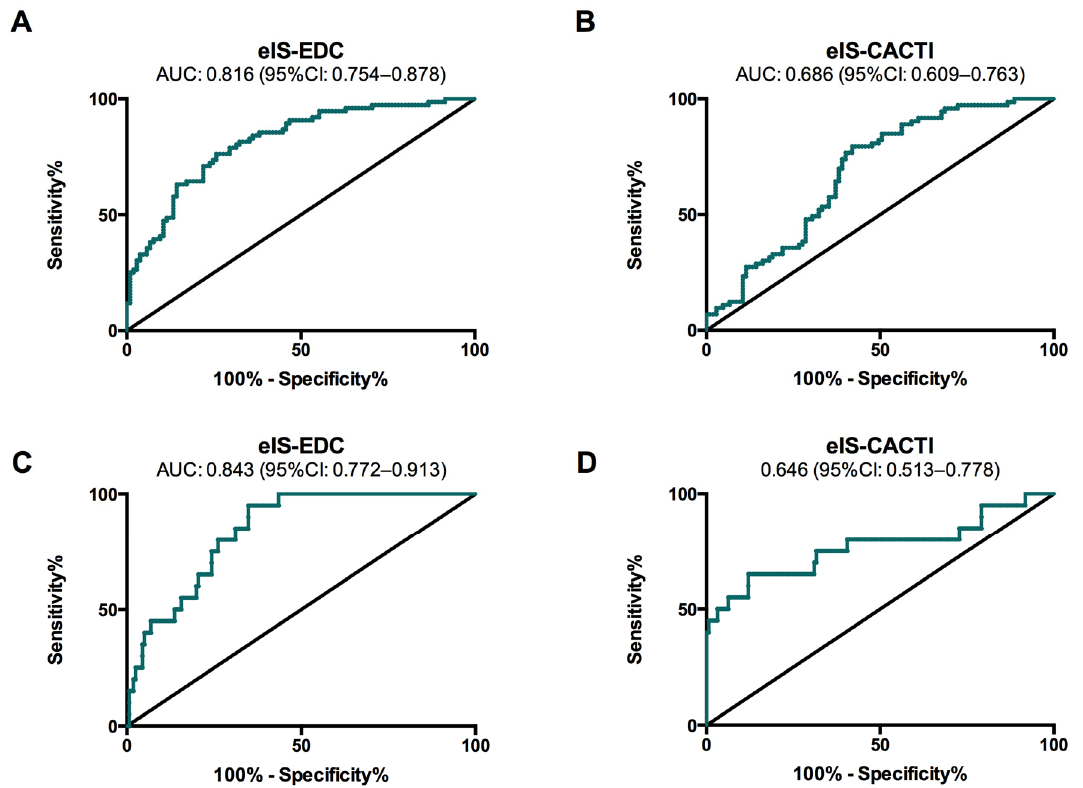
Figure 2. ROC curves for eIS-EDC and eIS-CACTI to identify cardiovascular risk according to the Steno Type 1 Risk Engine for moderate/high ( A , B ) and high-risk ( C , D ) groups.